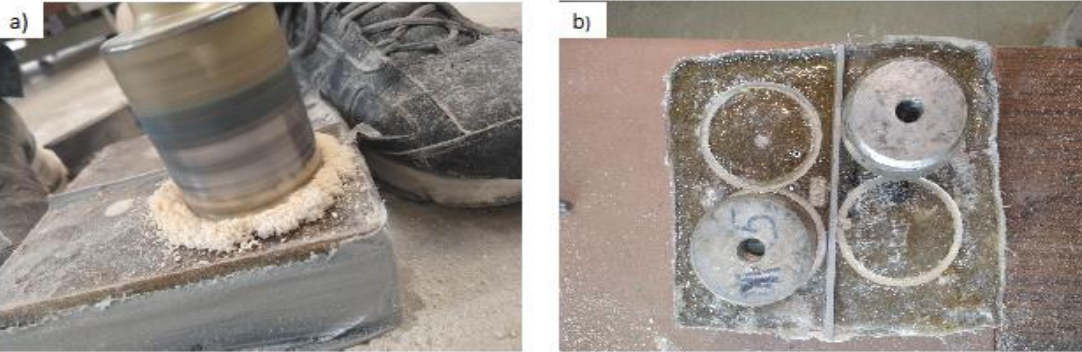
Figure 6. View of: ( a ) drilling holes for discs, ( b ) glued test discs.